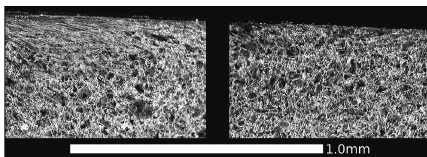
Figure 17: OM images of microstructure toward the field side of the tread (Region F1), showing the transition from sheared material (left, bordering the RCF band) to unsheared material in the region that is rarely in contact with the rails. The majority of Region F does not exhibit shearing of the microstructure.